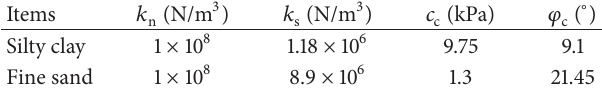
Table 3: Parameters of the interface element.